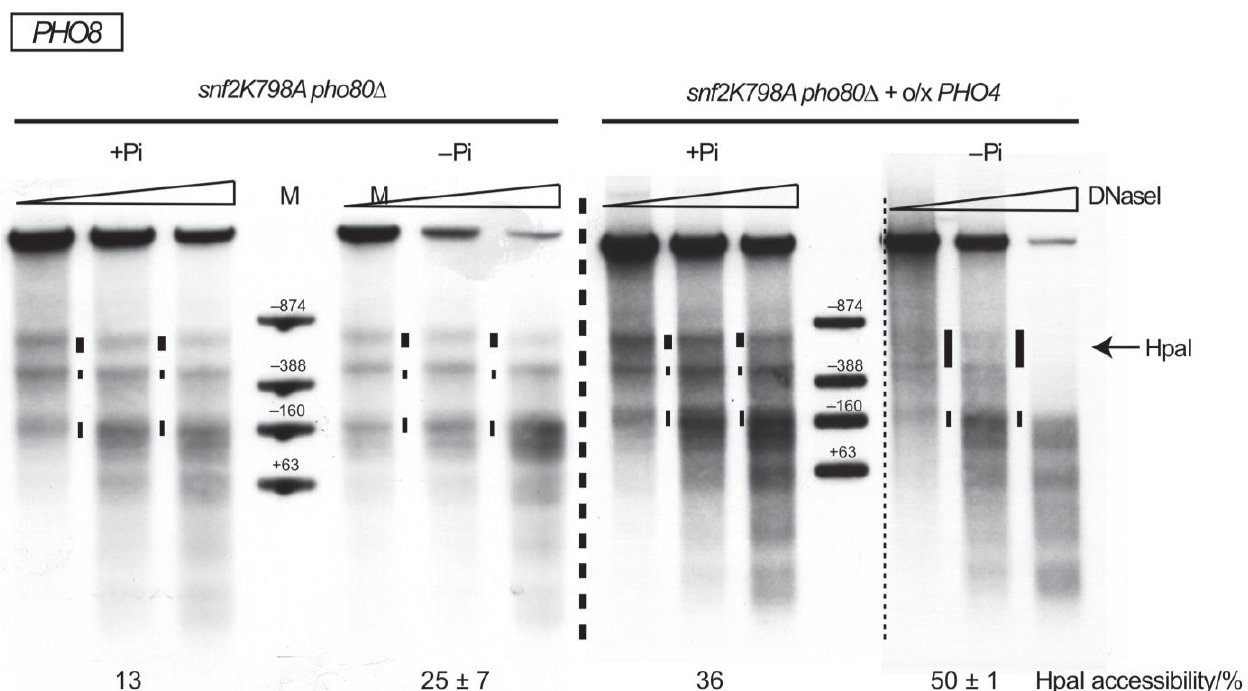
Figure 5. Enhanced induction by pho80 ∆ deletion allele only weakly increases PHO8 promoter opening in the absence of SWI/SNF activity. DNaseI indirect end labeling and corresponding HpaI accessibility values analogous to Figure 1B,C for the indicated genotypes and growth conditions. Thin dashed vertical line, as in Figure 3. Thick dashed vertical line separates samples electrophoresed in different gels.